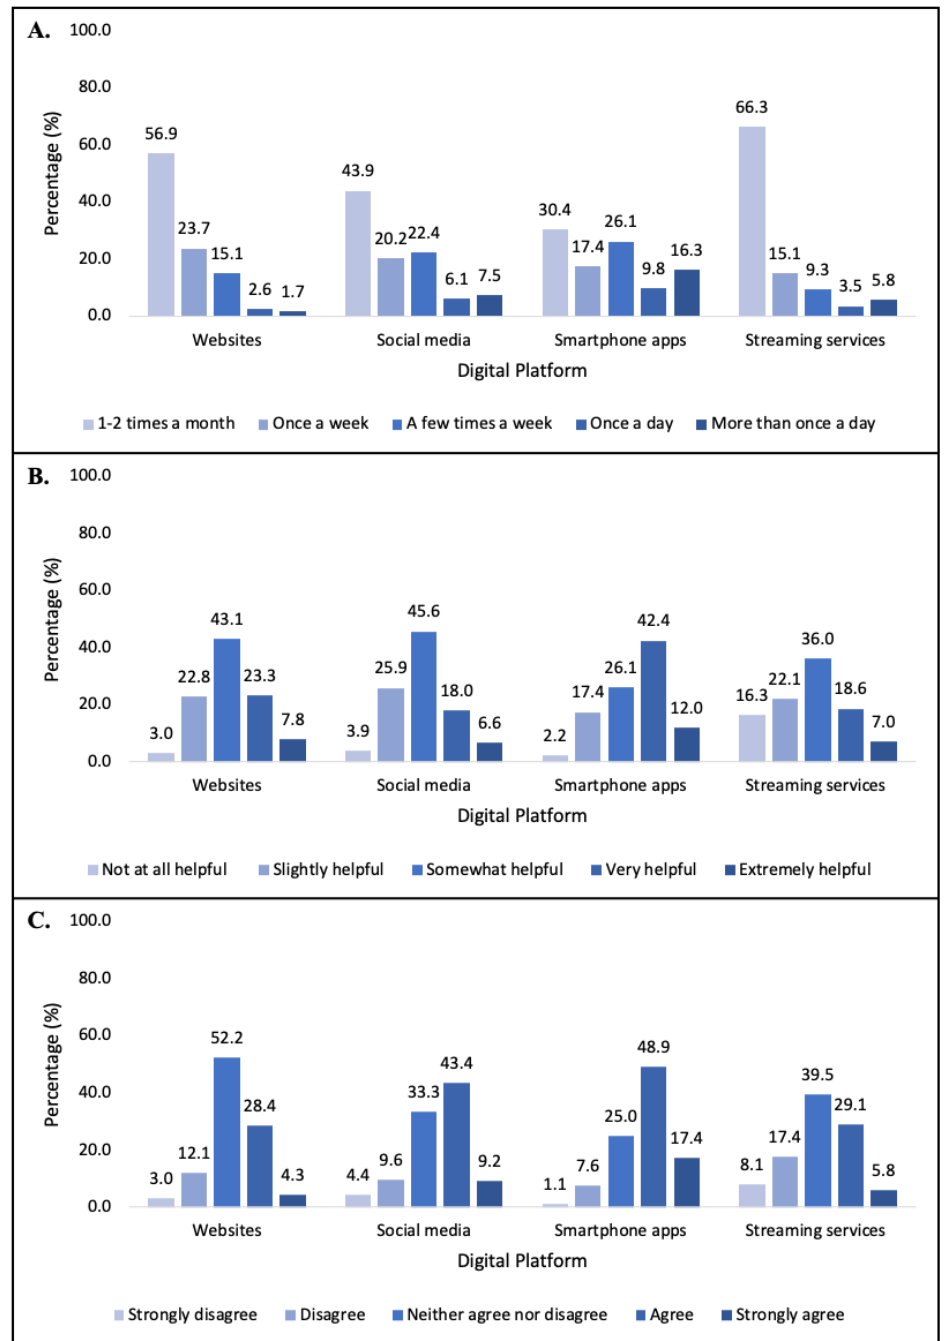
Figure 1. Survey items showing ( A ) Frequency of using digital platforms to access healthy lifestyle information; ( B ) Perceived helpfulness of digital platforms for accessing information and ( C ) Help- fulness of digital platforms for behaviour change.